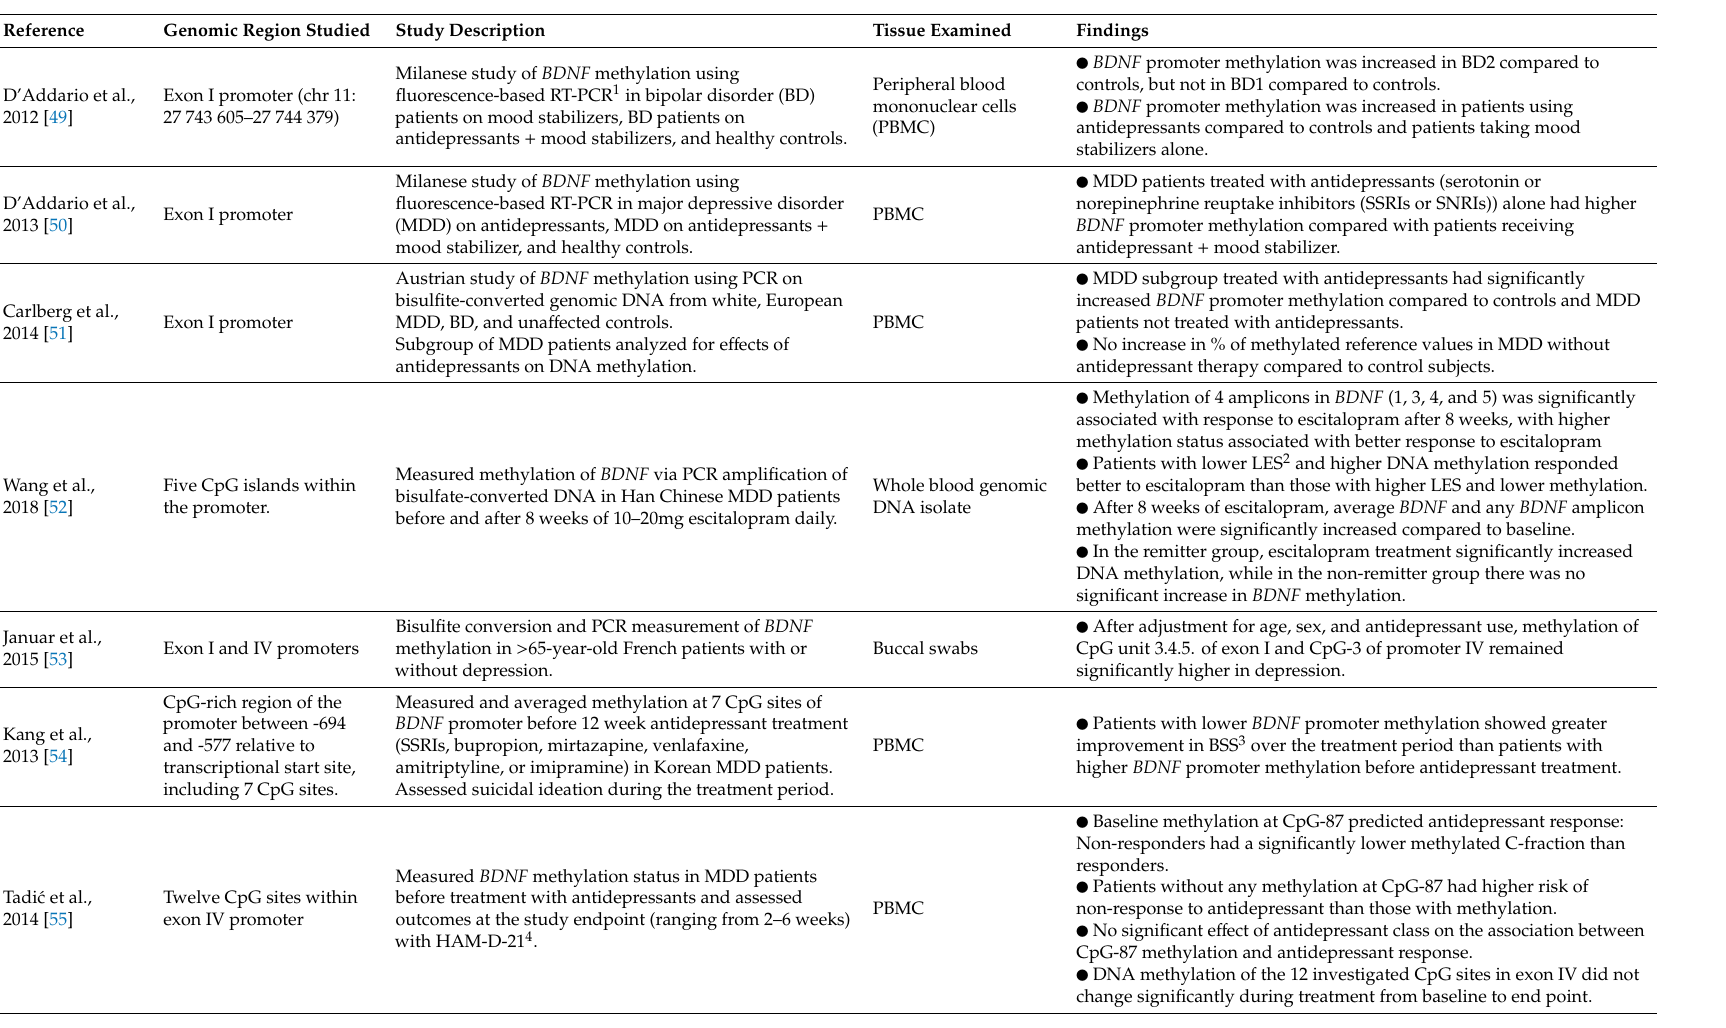
Table 1. Summaries of studies exploring relationship of antidepressants and BDNF DNA